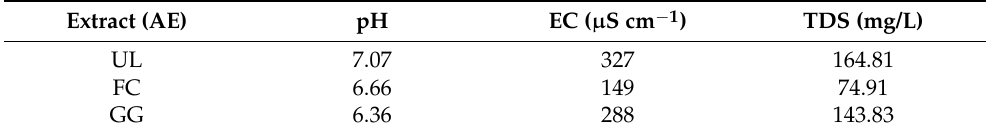
Table 4. Aqueous extract (AE) analysis of pH, electrical conductivity (EC) and total dissolved solids (TDS) from the, U. lactuca (UL), F. ceranoides (FC) and G. gracilis (GG) seaweed samples. Extract (AE)